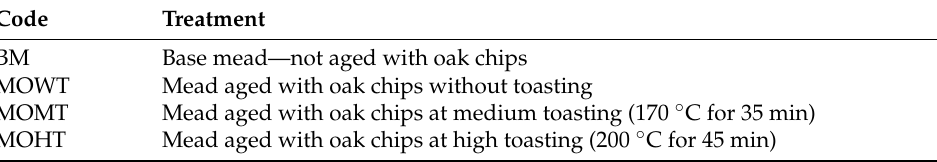
Table 2. Coding and characterization of treatments used in this